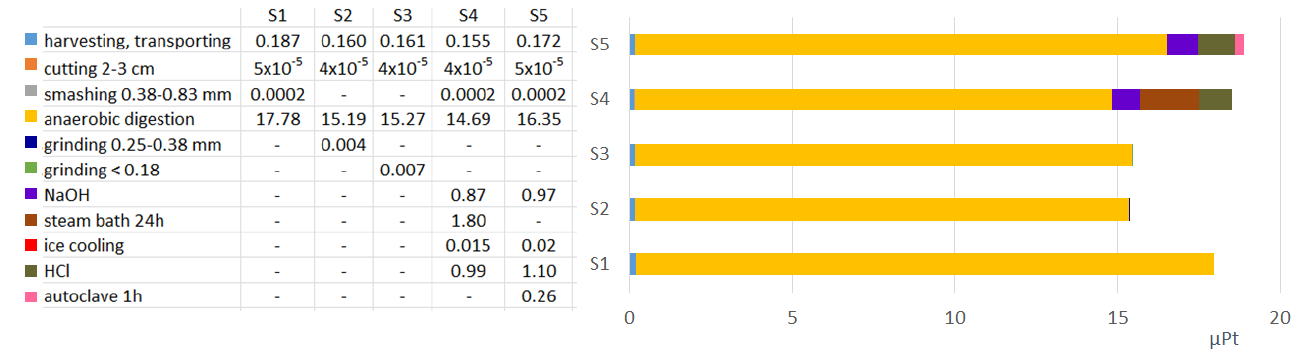
Figure 4. IMPACT 2002+ per 1 dm 3 of produced methane in the S1 – S5 processes.